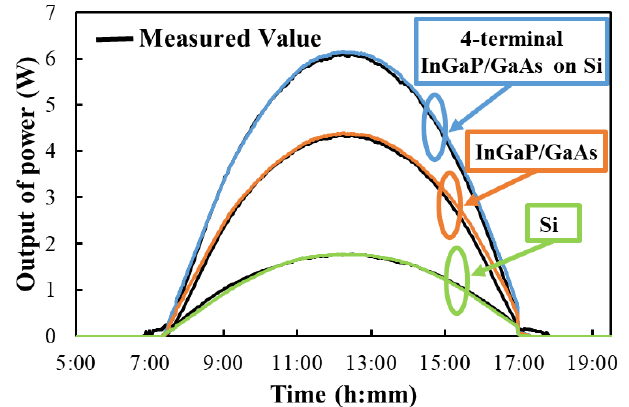
Figure 5. The performance model of the tandem solar cells, considering the spectrum and angle interaction [1].